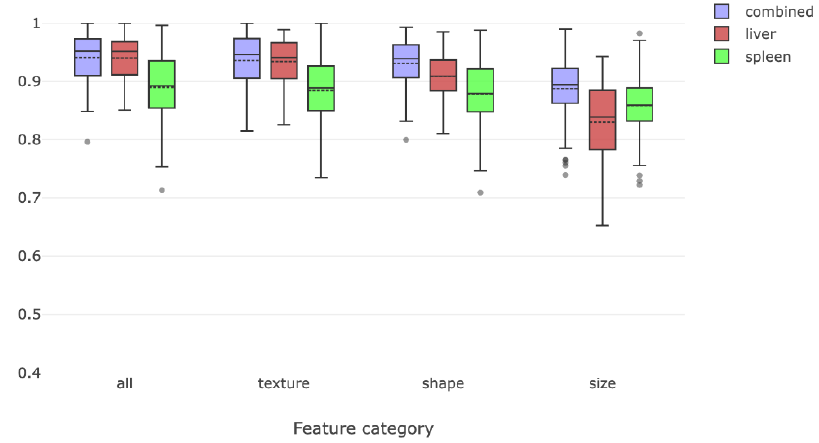
Figure 3. This figure compares the overall radiomic discrimination of cirrhosis between cirrhosis and non-cirrhosis cohorts. Liver features were somewhat more effective in discriminating between the two classes, with texture and shape features being more salient than size